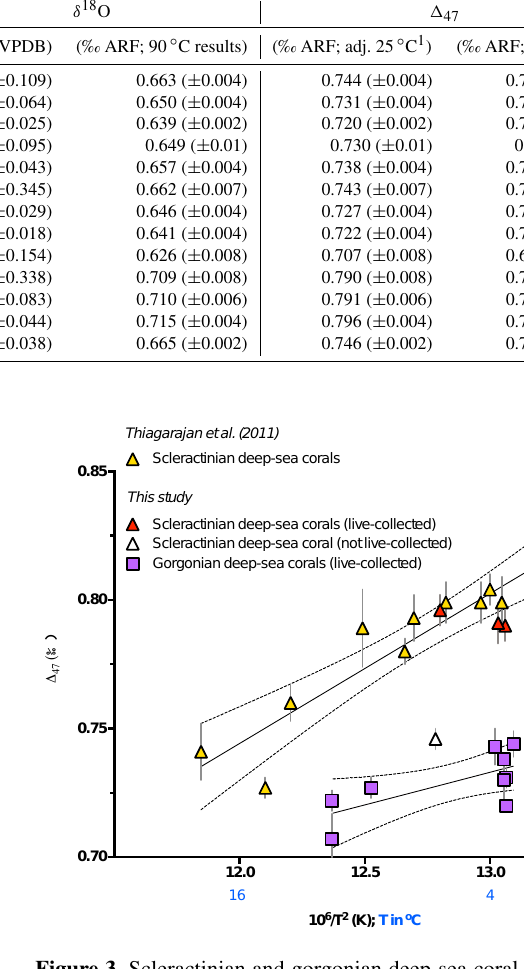
Figure 3. Scleractinian and gorgonian deep-sea coral compared to deep-sea corals reported in Thiagarajan et al. (2011) and average (cid:49) 47 values recalculated relative to ARF from Eagle et al. (2013). Sample 703-7 is not included in the calibration and is not considered